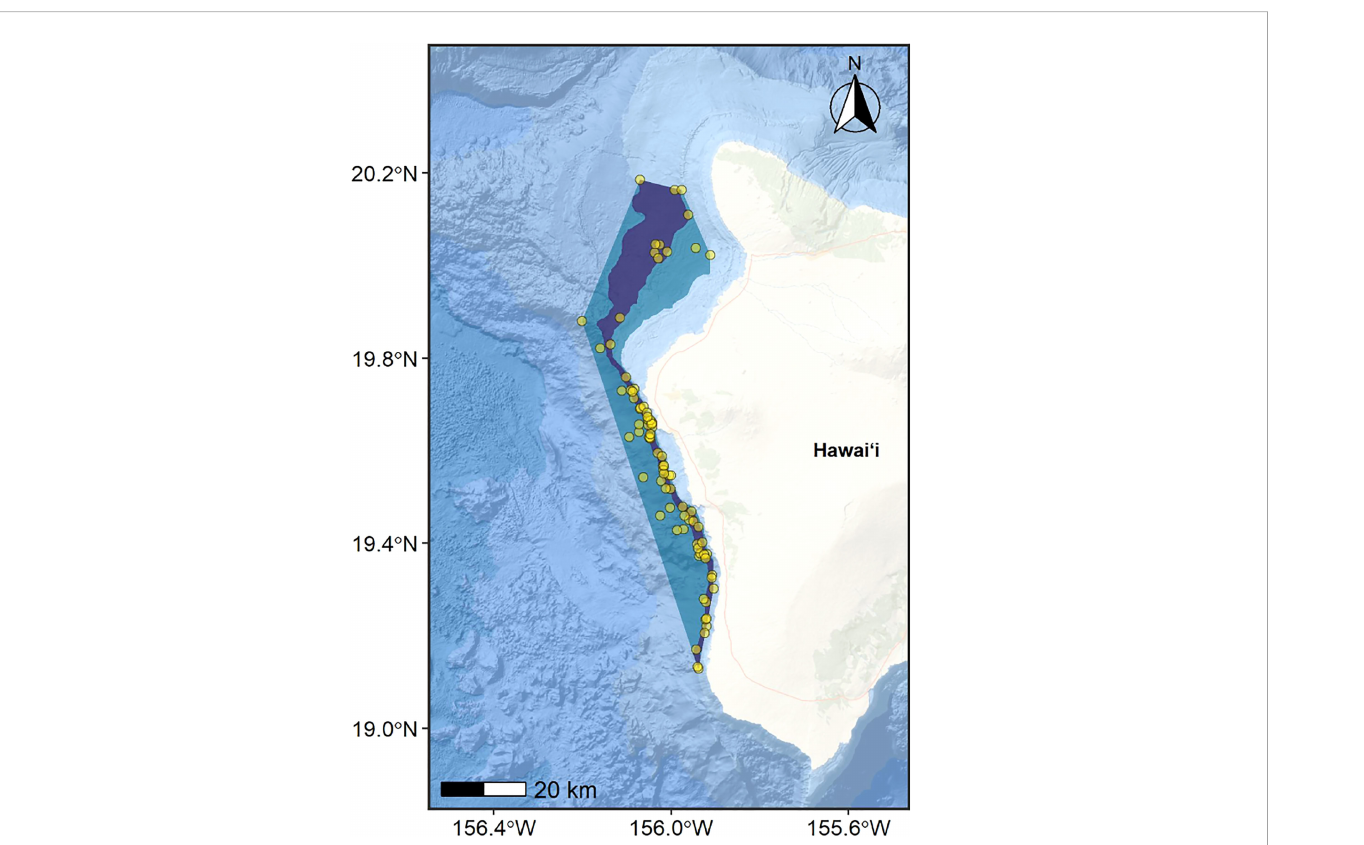
FIGURE 2 Parent BIA boundary (blue polygon) for the Hawai ʻ i Island dwarf sperm whale population represented as a minimum convex polygon (MCP) encompassing all sighting locations in less than 2,000 m water depth (yellow circles), and child BIA boundary (core range; purple polygon) represented as the area between the 500-m and 1,000-m isobaths within the parent BIA. Points are partially transparent to highlight high density areas (i.e., where multiple points overlap). The inner (shoreward) boundary for both BIAs is de fi ned as the 300-m isobath. Total area of the parent BIA = 1,341 km 2 and child BIA = 457 km 2 . Basemap image is the intellectual property of Esri and is used herein with permission. Copyright © 2022 Esri and its licensors. All rights